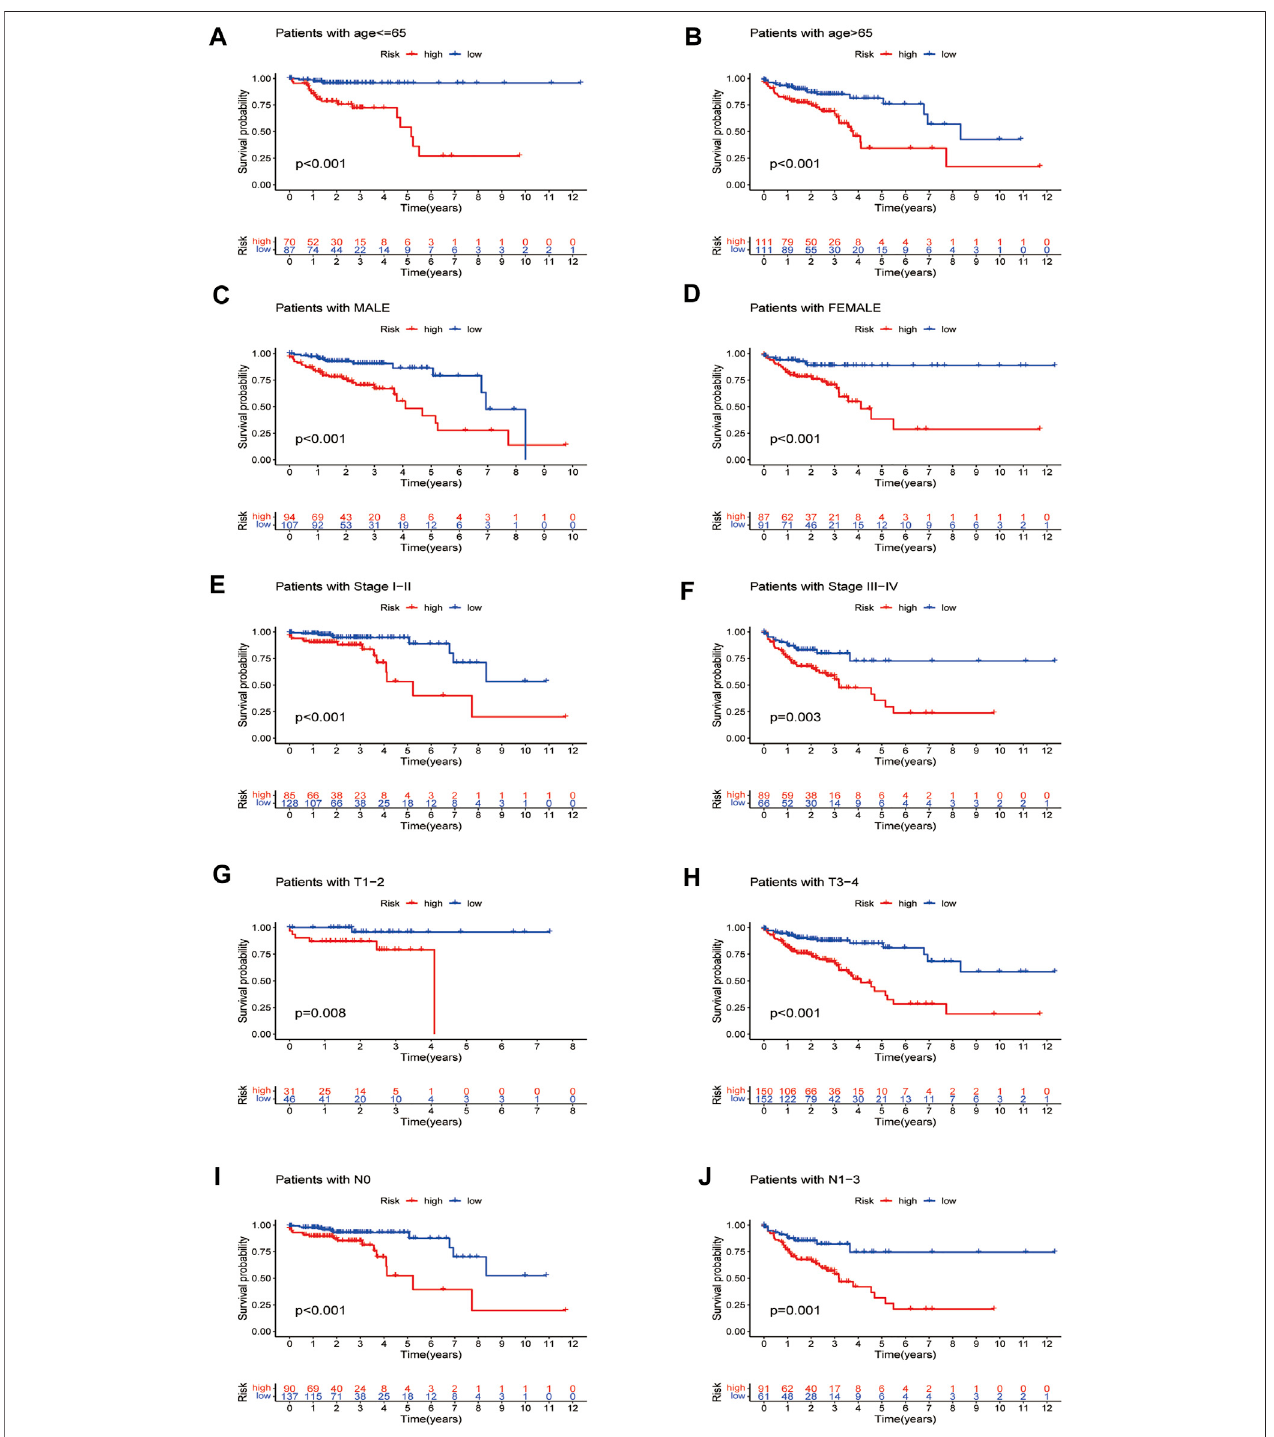
FIGURE 8 | Survival curves for model validation (our prognostic model applied to different clinical groups: age, gender, stage, and T and N staging, p < 0.05).